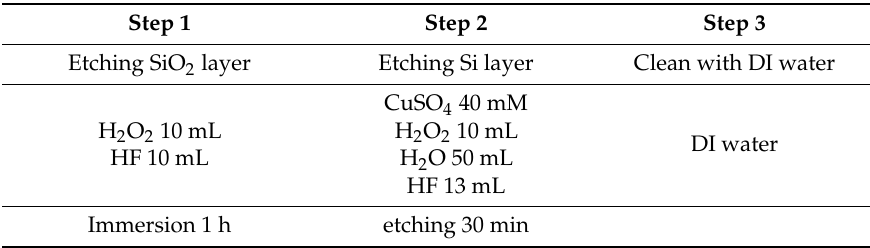
Table 1. Process Parameters for Etching Holes in Silicon Wafers.